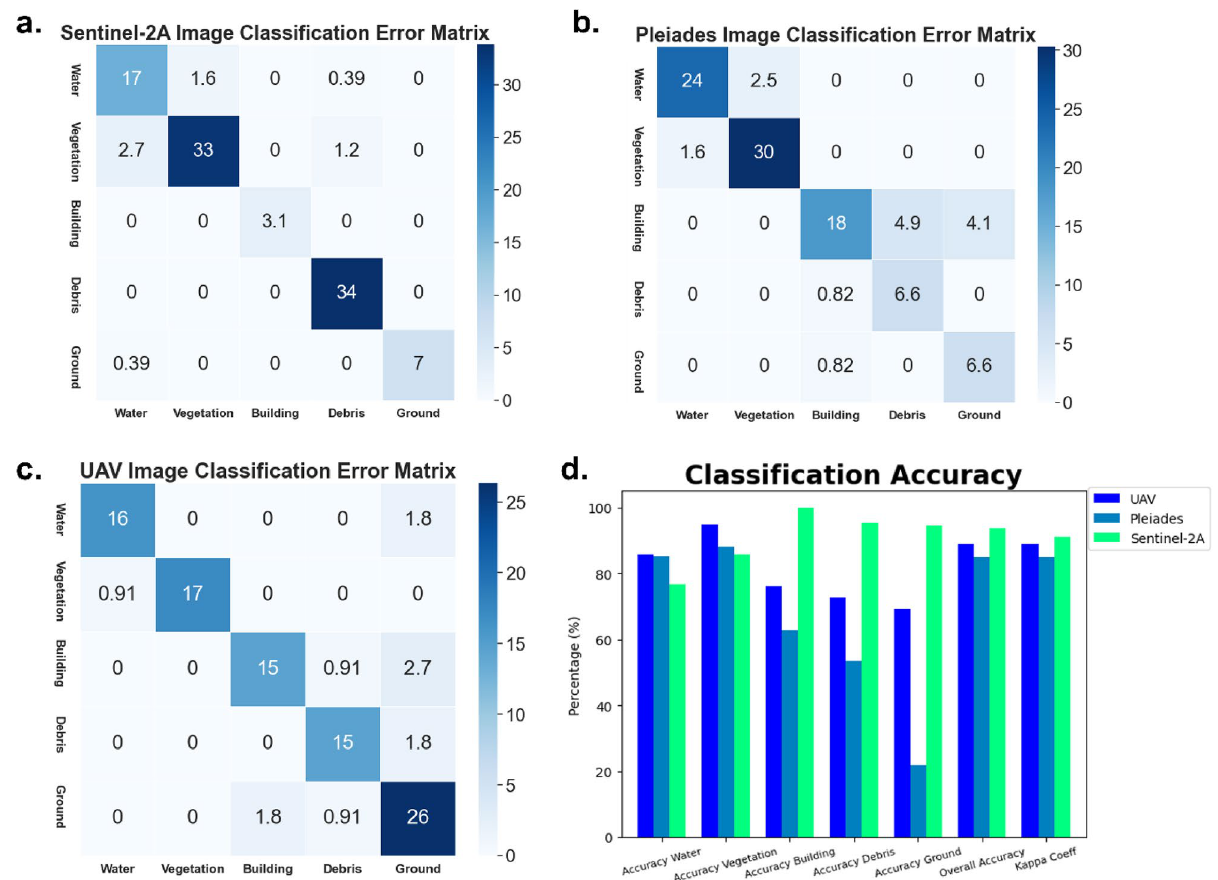
Figure 8. Results of the classification error matrix percentage on: (a). Sentinel-2A imagery, (b) . Pleiades imagery, (c) UAV photogrammetry and (d) classification accuracy percentage for the three